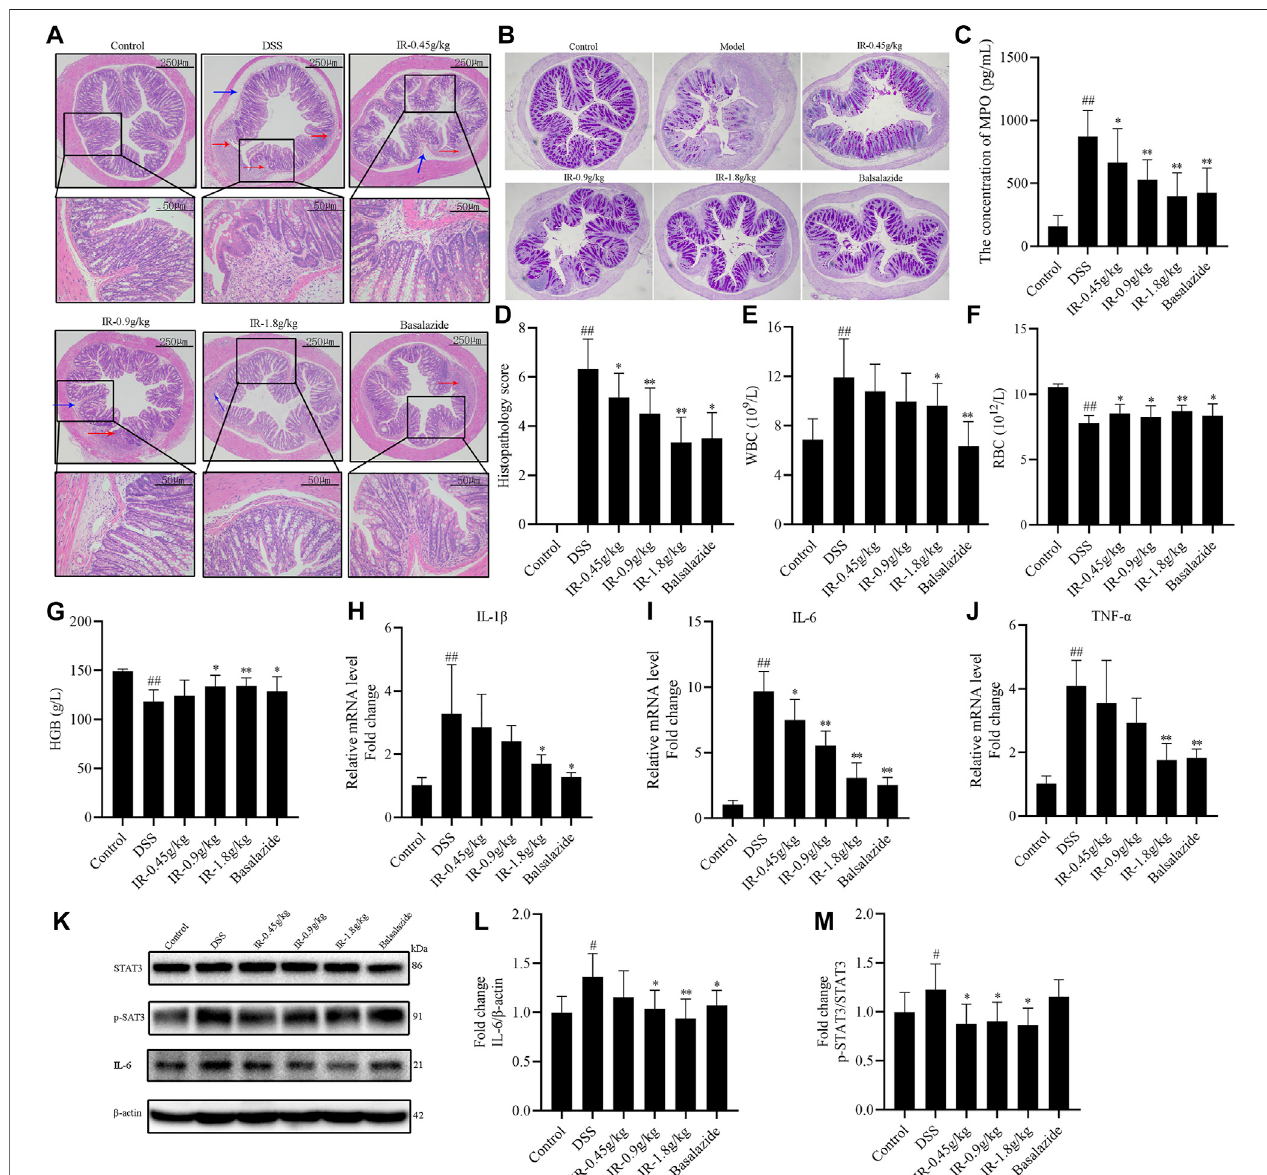
FIGURE 3 | IR suppress in fl ammation of UC mice. (A) Representative H & E staining colon tissue of mice (day 56). (B) PAS staining colon tissue of mice (day 56). (C) MPOcontentwasmeasuredbyELISAinserumofmice. (D) Histopathologyscores. (E) ThenumberofWBCineachgroupofmicetestedbyroutineanalysisofblood. (F) The numberofRBCineachgroupofmice. (G) TheconcentrationofHGBineachgroupofmicetestedbyroutineanalysisofblood. (H – J) ThemRNAlevelsofIL-1 β ,IL-6,andTNF- α fromthecolon ofmice. (K) The protein levelsofSTAT3,p-STAT3,and IL-6incolon detectedbywestern blotting. (L) Thegrayintensity analysisofIL-6. (M) Thegray intensity analysis of p-STAT3/STAT3. All data were compared using one-way ANOVA, and p -values re fl ected differences between experimental